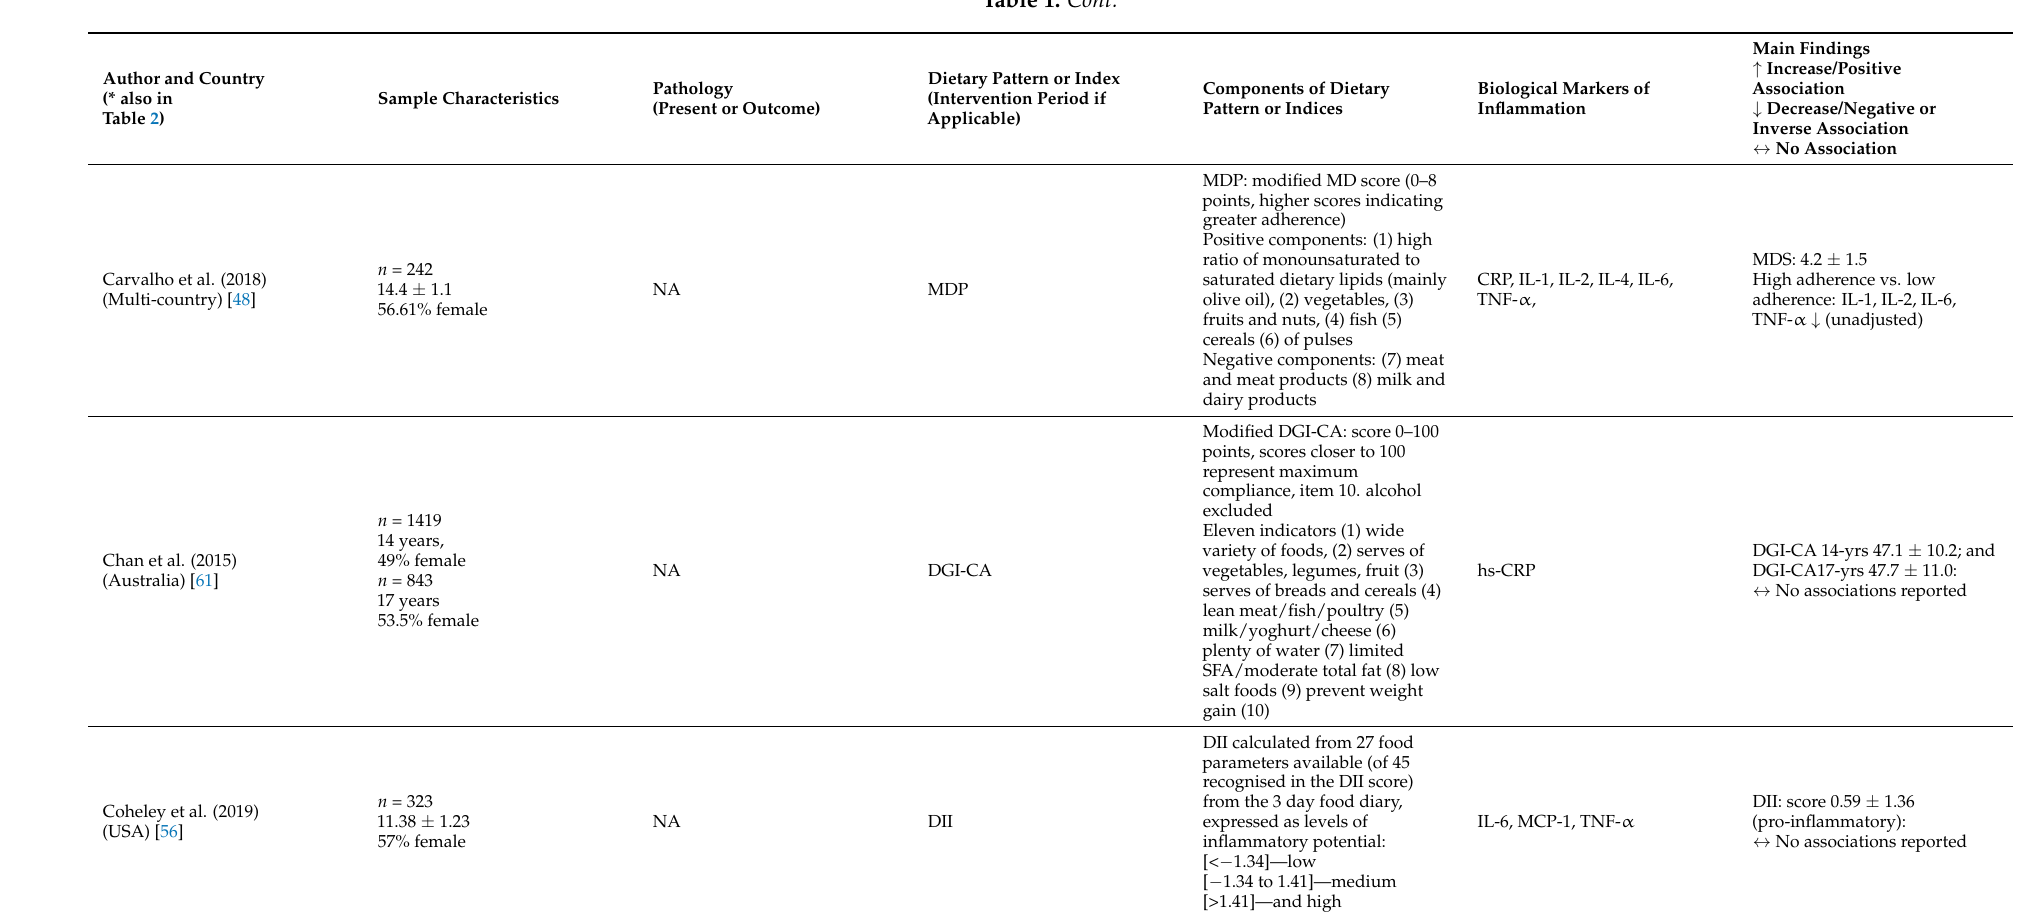
Sample Characteristics Pathology (Present or